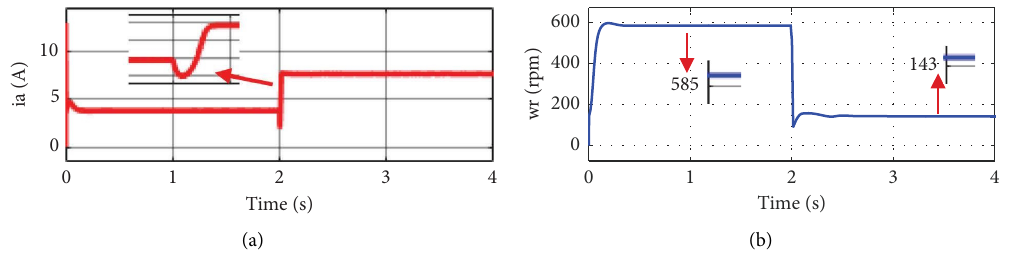
Figure 28: Series DC motor specifcation in the third mode. (a) Armature current. (b) Speed of DC motor (rpm).